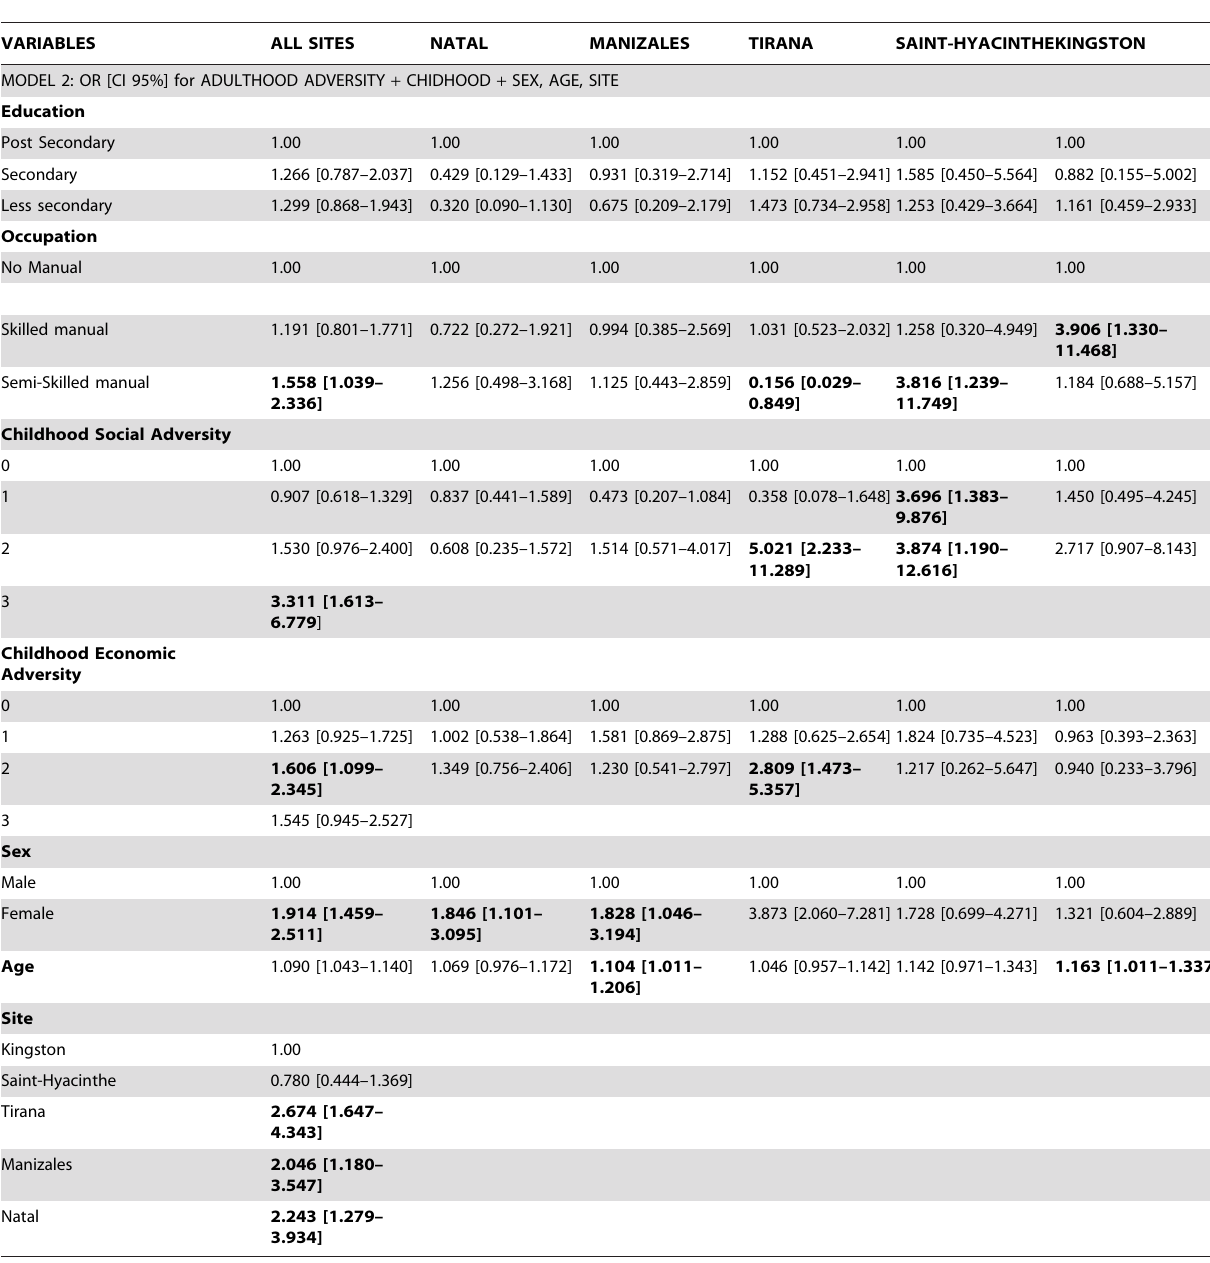
Table 4. Associations between Adulthood Adversity and Poor Physical Performance (SPPB , 8).